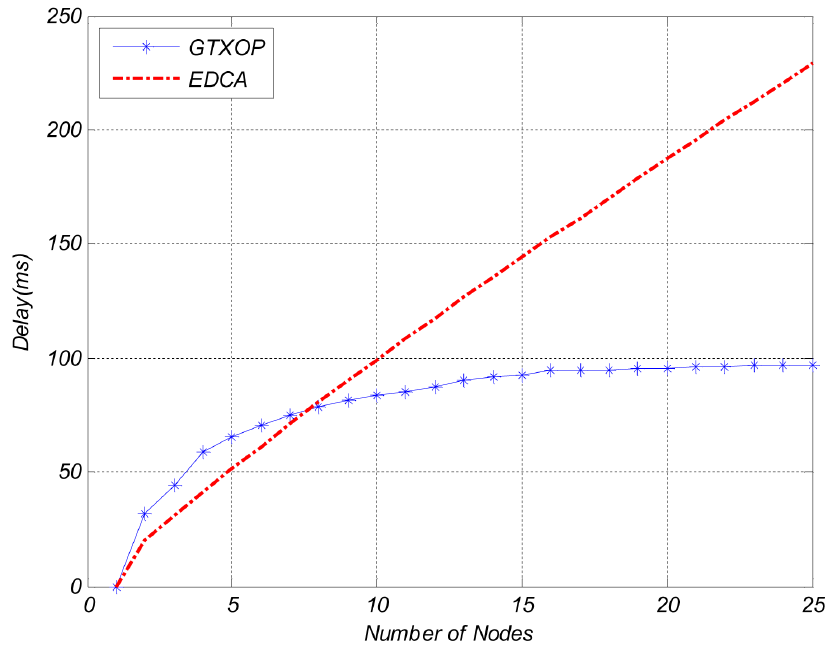
Figure 3. Delay Comparison of GTXOP and EDCA.